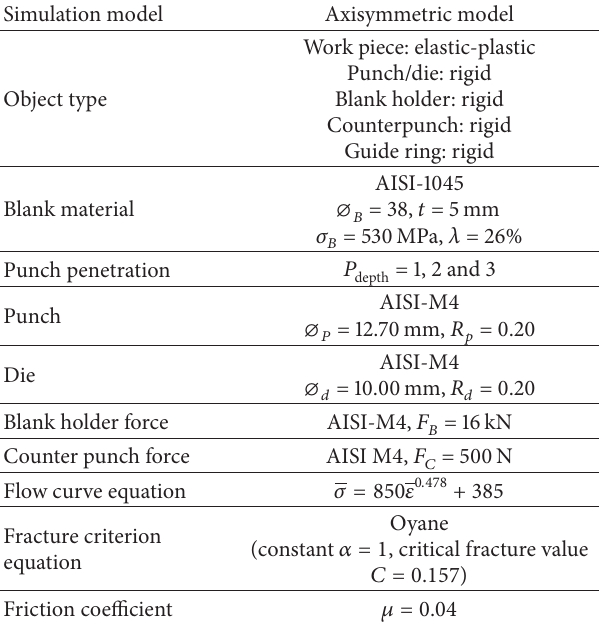
Table 1: FEM simulation